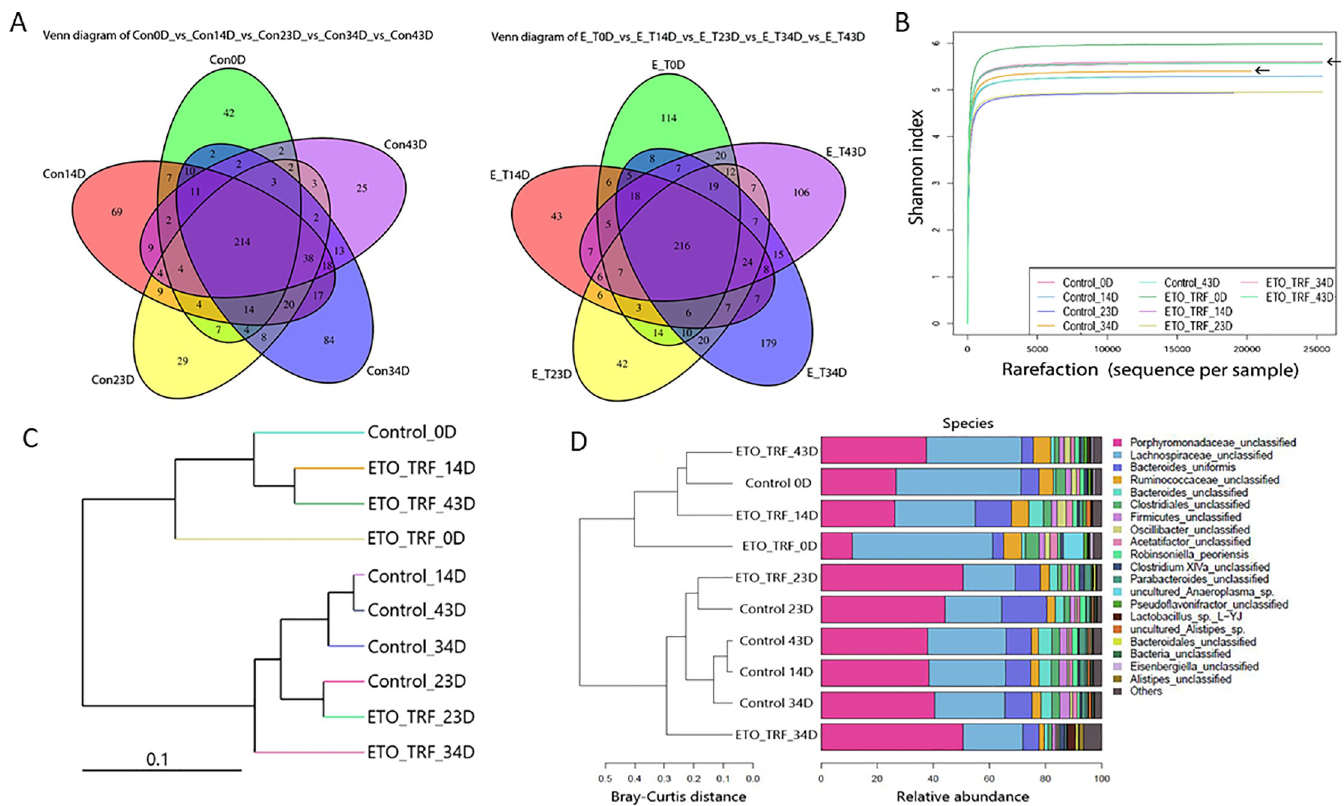
Fig 2. Venn diagram showing the shifting of microbial OTUs between control and ETO-Cur-TRF treated mice feces from 0 days to 43 days (A). Values were obtained from purified DNA pooled from 3–4 mice in each group. Venn diagram shows the similarity and specificity of OTU in different samples/groups. Each circle in Venn diagram stands for a sample. The overlapped region shows the number of common OTUs and non–overlapped region showed the number of common OTUs and non overlapped region shows the number of unique OTUs. Alpha diversity shows that the combination of ETO-Cur-TRF increases species diversity and richness in treated mice. Rarefaction curves are plotted by Shannon index showing the OTUs/species abundance in different days and that the species richness increased on 34day as indicated by arrows (B). Alpha diversity was determined using QIIME. ETO-Cur-TRF treated mice shows the differential distribution of microbial communities. Beta diversity analysis shows the relative abundance of microbial communities using distant matrix as determined by UPGMA Weighted-UniFrac clustering of microbial OTU/species sequence in different samples. The distance suggests differences in microbial composition in samples (C) and Bray-Curtis plot shows the differences of microbial species abundance in community